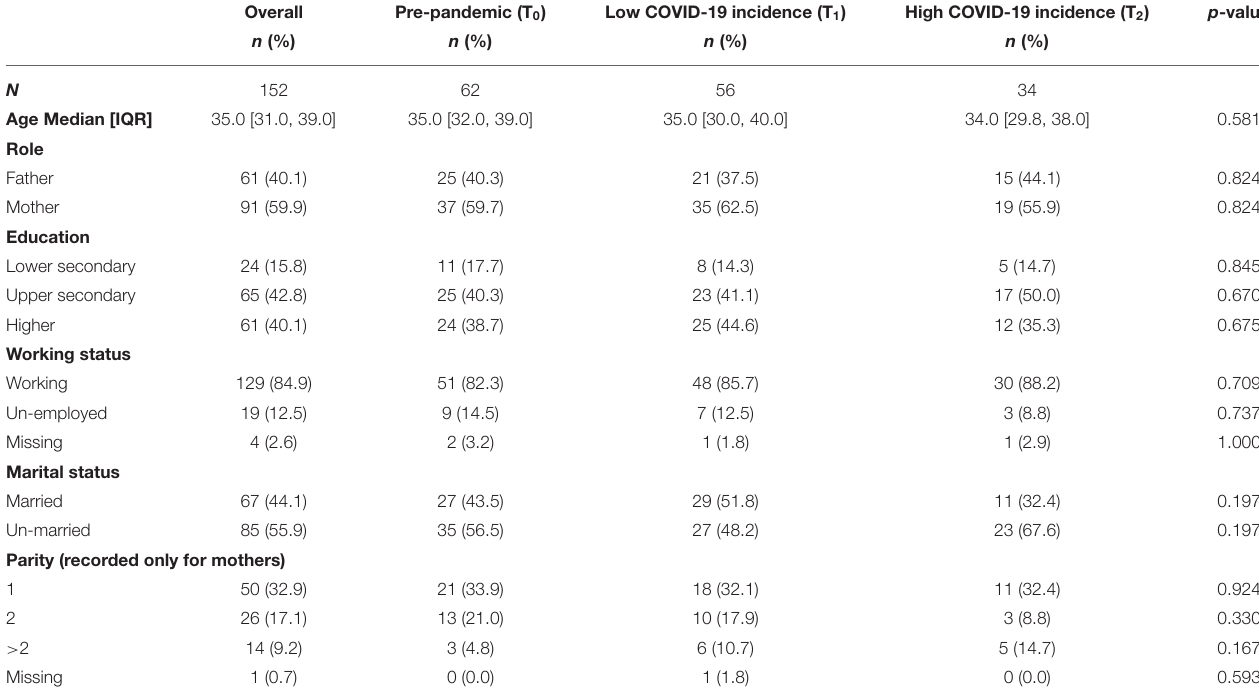
TABLE 1 | Parents’ characteristics during three COVID-19 pandemic periods. Overall Pre-pandemic (T 0